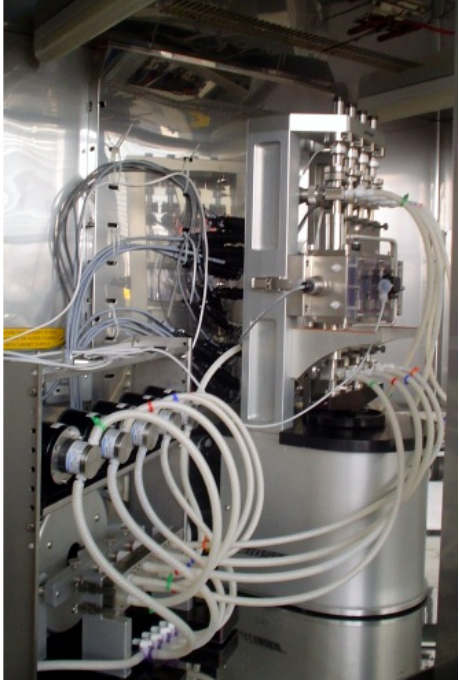
Figure 1. The tri-axial bioreactor.